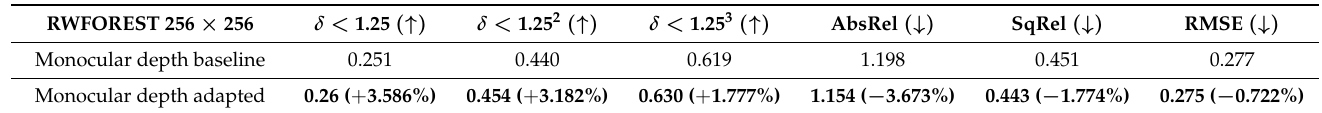
Table 3. Comparison of adapted and baseline depth estimation networks on RWFOREST dataset.